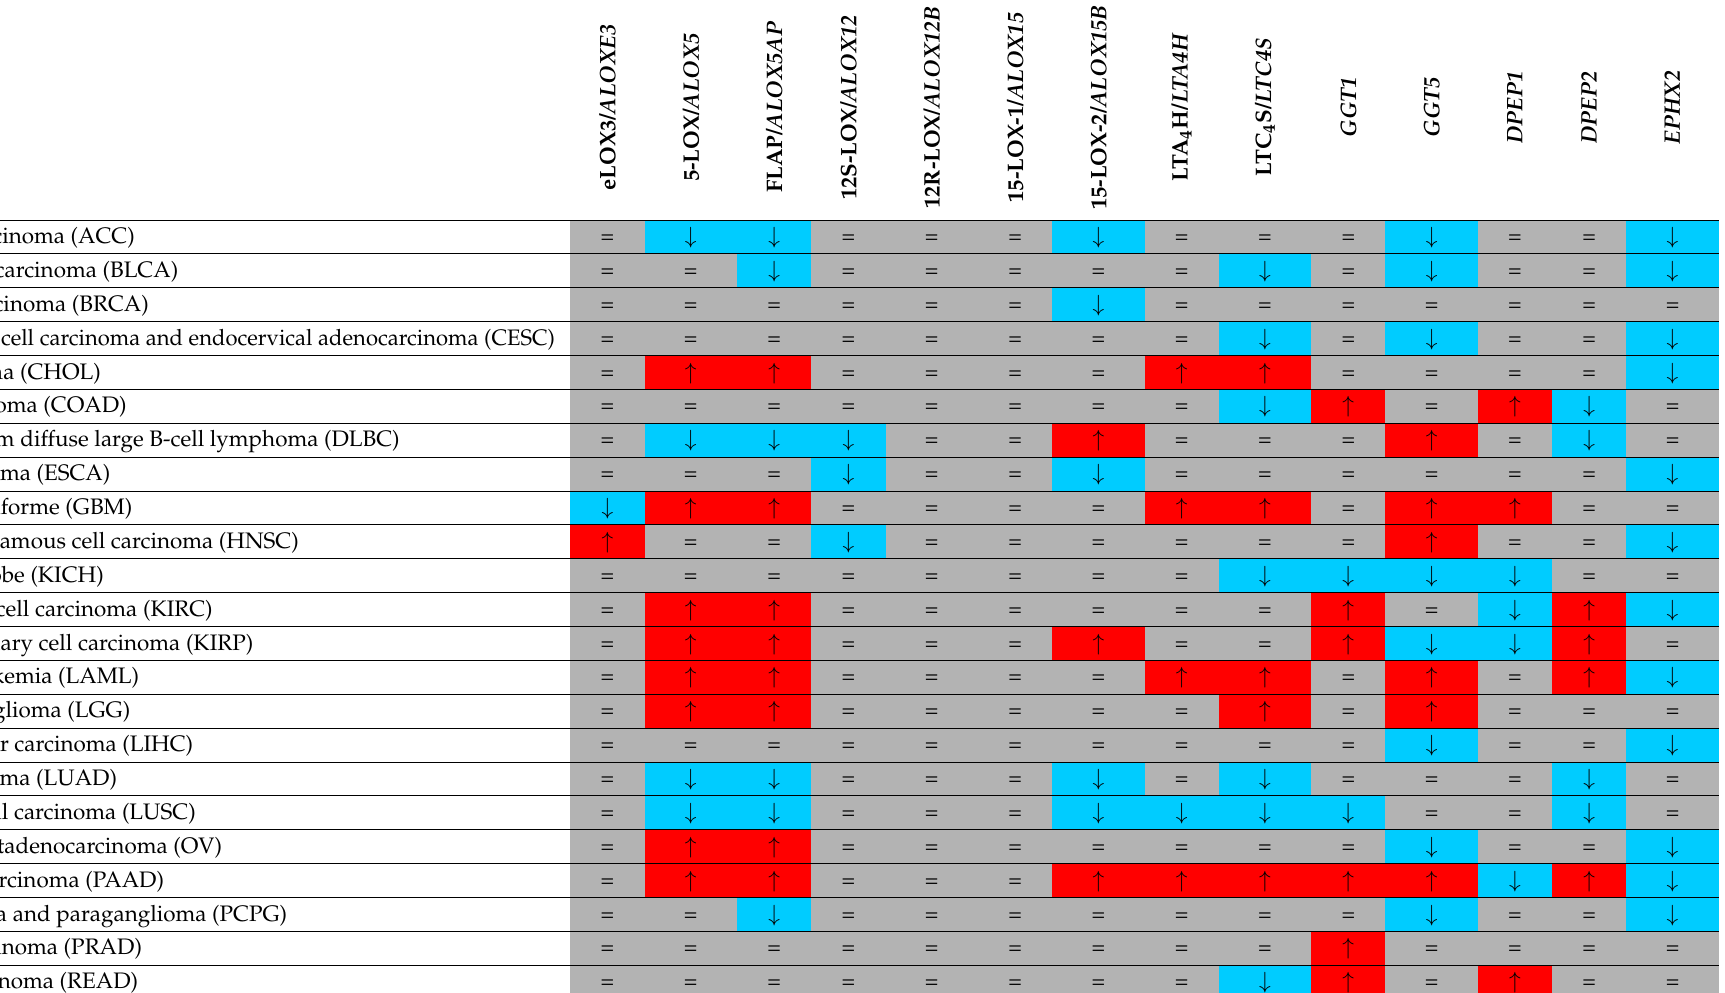
Table 8. Pan-cancer analysis of expression of genes involved in the LOX